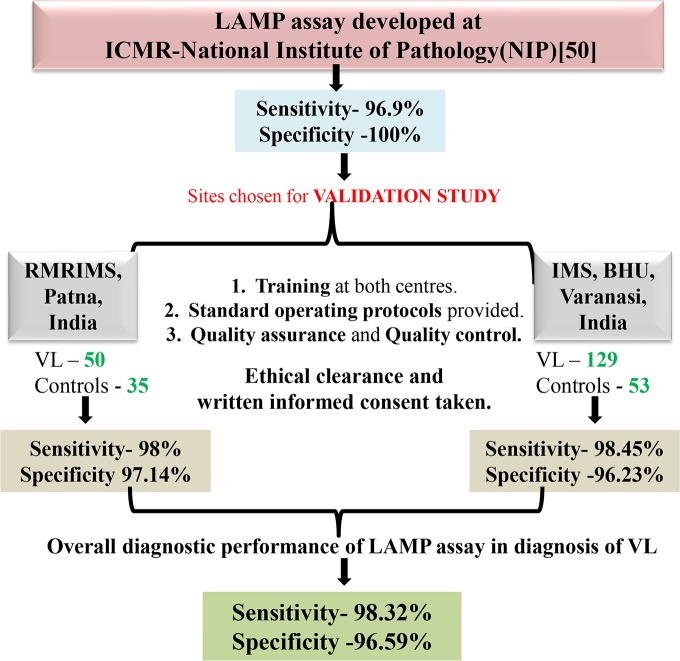
Schematic representation of procedure and results obtained for validation study of LAMP assay at RMRIMS, Patna, India and IMS, BHU, Varanasi, India.Sensitivity and specificity of DBL-LAMP assay for diagnosis of VL.